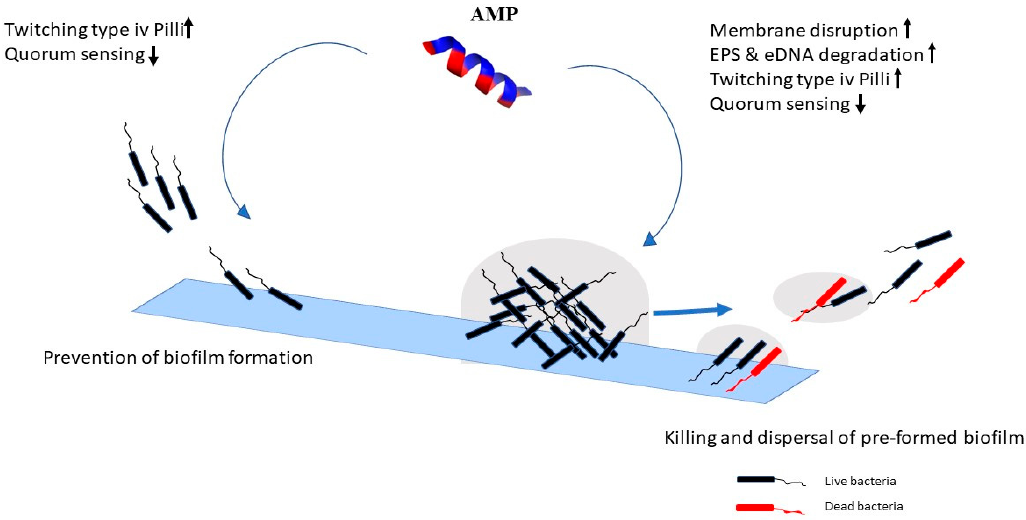
Figure 1. Anti-biofilm activity and mechanism of action of antimicrobial peptides (AMPs). AMPs effect mainly involve prevention of bacterial attachment and inhibition of biofilm formation or disruption of pre-formed biofilms. activation inhibition.